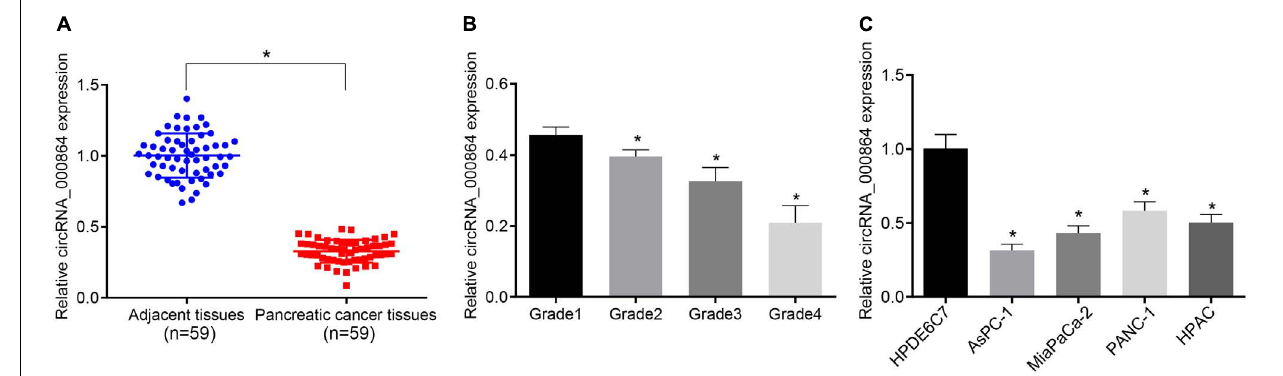
FIGURE 2 | Downregulation of circRNA_000864 is observed in pancreatic cancer tissues and cells. (A) circRNA_000864 expression in pancreatic cancer tissues and adjacent normal tissues determined by RT-qPCR normalized to GAPDH (n = 59). (B) The expression of circRNA_000864 in different stages of pancreatic cancer (Grade 1 = 6, Grade 2 = 9, Grade 3 = 33, Grade 4 = 11). (C) The expression of circRNA_000864 in normal pancreatic epithelial cell lines and pancreatic cancer cell lines were detected by RT-qPCR normalized to GAPDH. * p < 0.05 vs. adjacent normal tissues or patients at Grade 1 or HPDE6C7 cells. The above data were all measurement data. The statistical results of (A,B) were expressed as mean ± standard deviation. Data of (A) were compared by the paired t -test, and data of (B) were compared by one-way ANOVA (Dunnett’s post hoc test). The statistical results in (C) were expressed as sample mean ± standard error and compared by using one-way ANOVA, and the cell experiment was conducted three times independently.